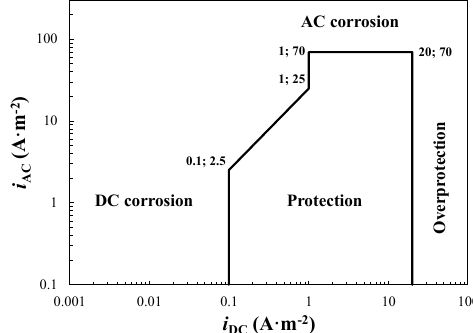
Figure 4. Acceptable AC interference levels based on current densities criterion according to Kajiyama et al. (adapted from [56]).